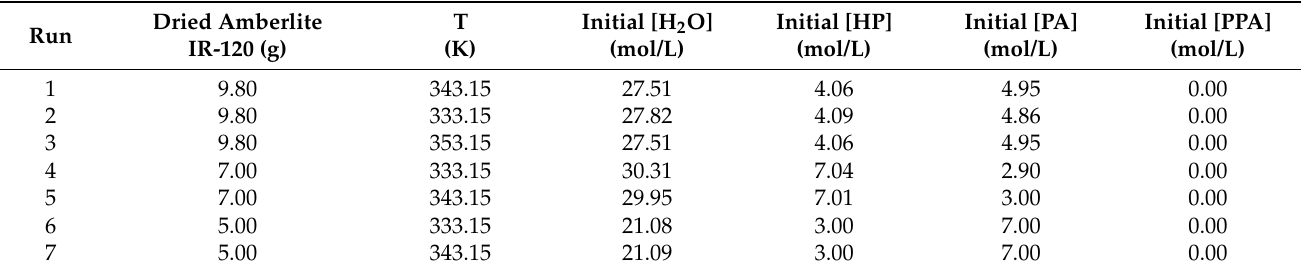
Table 3. Experimental matrix for the modeling of propionic acid perhydrolysis. (HP: hydrogen peroxide, PA: propionic acid, and PPA: perpropionic acid).